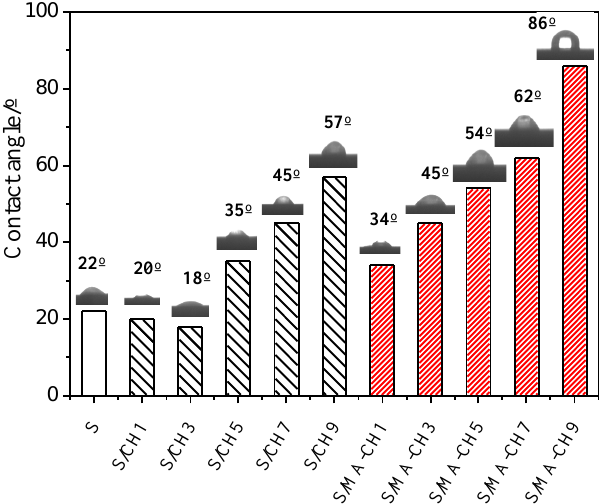
Figure 5. Water contact angle of S films, S / CH 1% films, S / CH 3% films, S / CH 5% films, S / CH 7% films, S / CH 9%, S / MA-CH 1% films, S / MA-CH 3% films, S / MA-CH 5% films, S / MA-CH 7% films, and S / MA-CH 9% films.